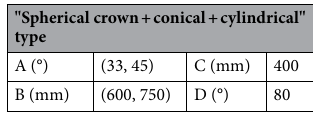
Table 3. Basic parameter setting.